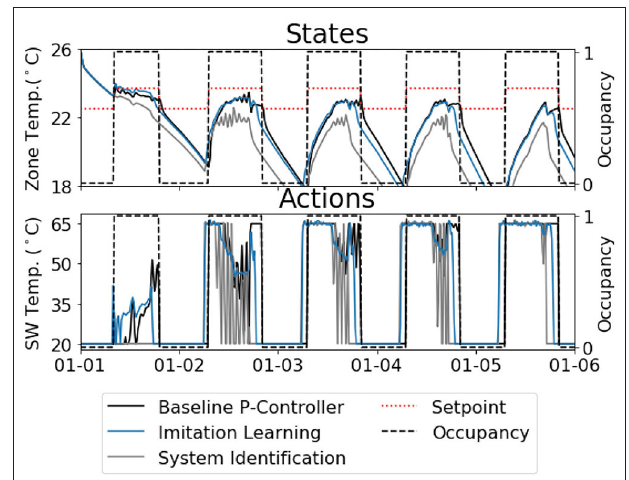
FIGURE 6 | Comparison of two initialization schemes: imitation learning vs. system identification (evaluated on TMY3 weather sequence); The agent initialized with imitation learning behaved similarly to the baseline P-controller, while the agent initialized with system identification consistently underestimated the heat requirement. Both agents were initialized with the same information, i.e., export demonstration from the baseline